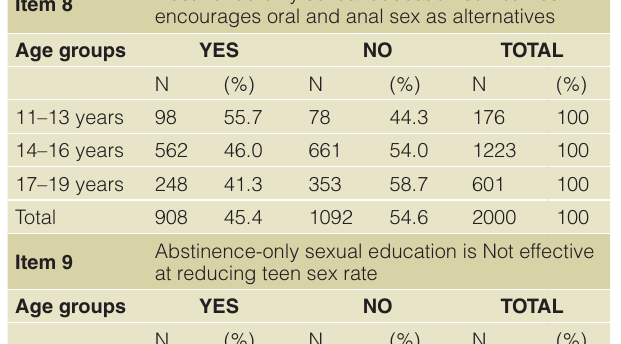
Table 3. Perspective of adolescents according to age group on the disadvantages of abstinence-only sexual education. Item 8